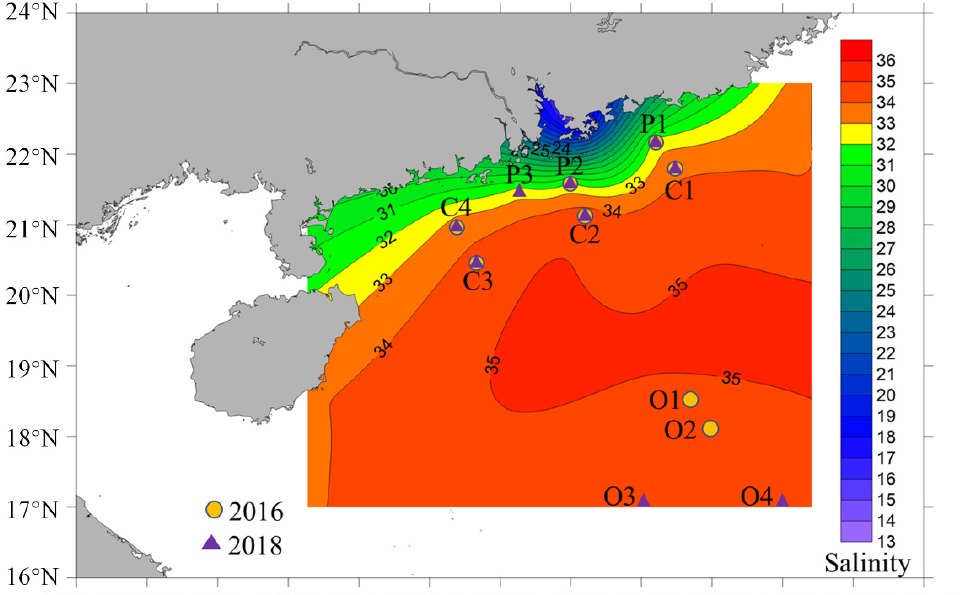
Figure 1. Map of sampling stations in the South China Sea. Plume stations: P1–P3; Offshore stations: C1–C4; Pelagic stations: O1–O4.